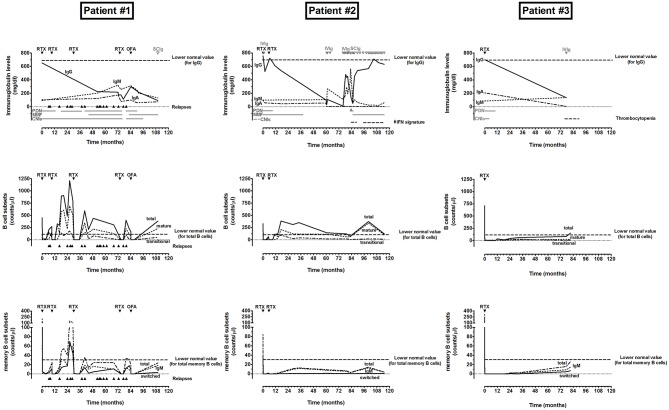
Monitoring of disease course, immunoglobulin and B-cell subset levels in INS patients who developed a severe de-novo hypogammaglobulinemia following anti-CD20 treatment. RTX, rituximab; OFA, ofatumumab; SCIg, subcutaneous immunoglobulin infusion; IVIg, intravenous immunoglobulin infusion; PDN, prednisone; MMF, mycophenolate mofetil; CNIs, calcinuerin inhibitors, IFN, interferon.